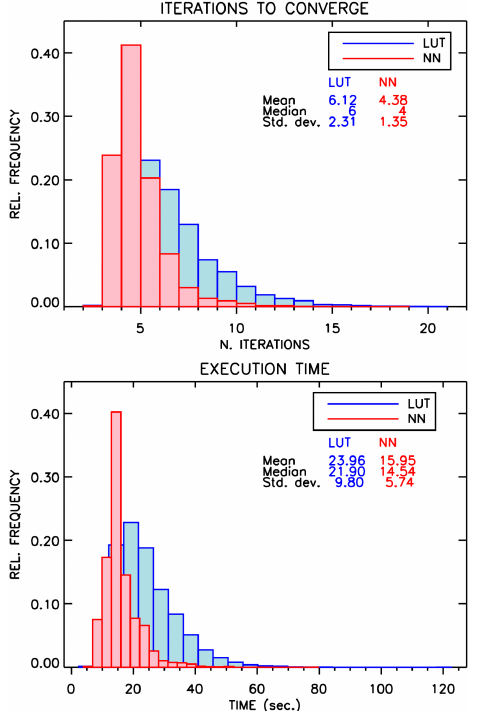
Figure 3. Histograms of the number of iterations before conver- gence (above) and of the total retrieval time (below) for the Phillips– Tikhonov retrievals using the LUT first guess (blue) and the NN first guess (red).